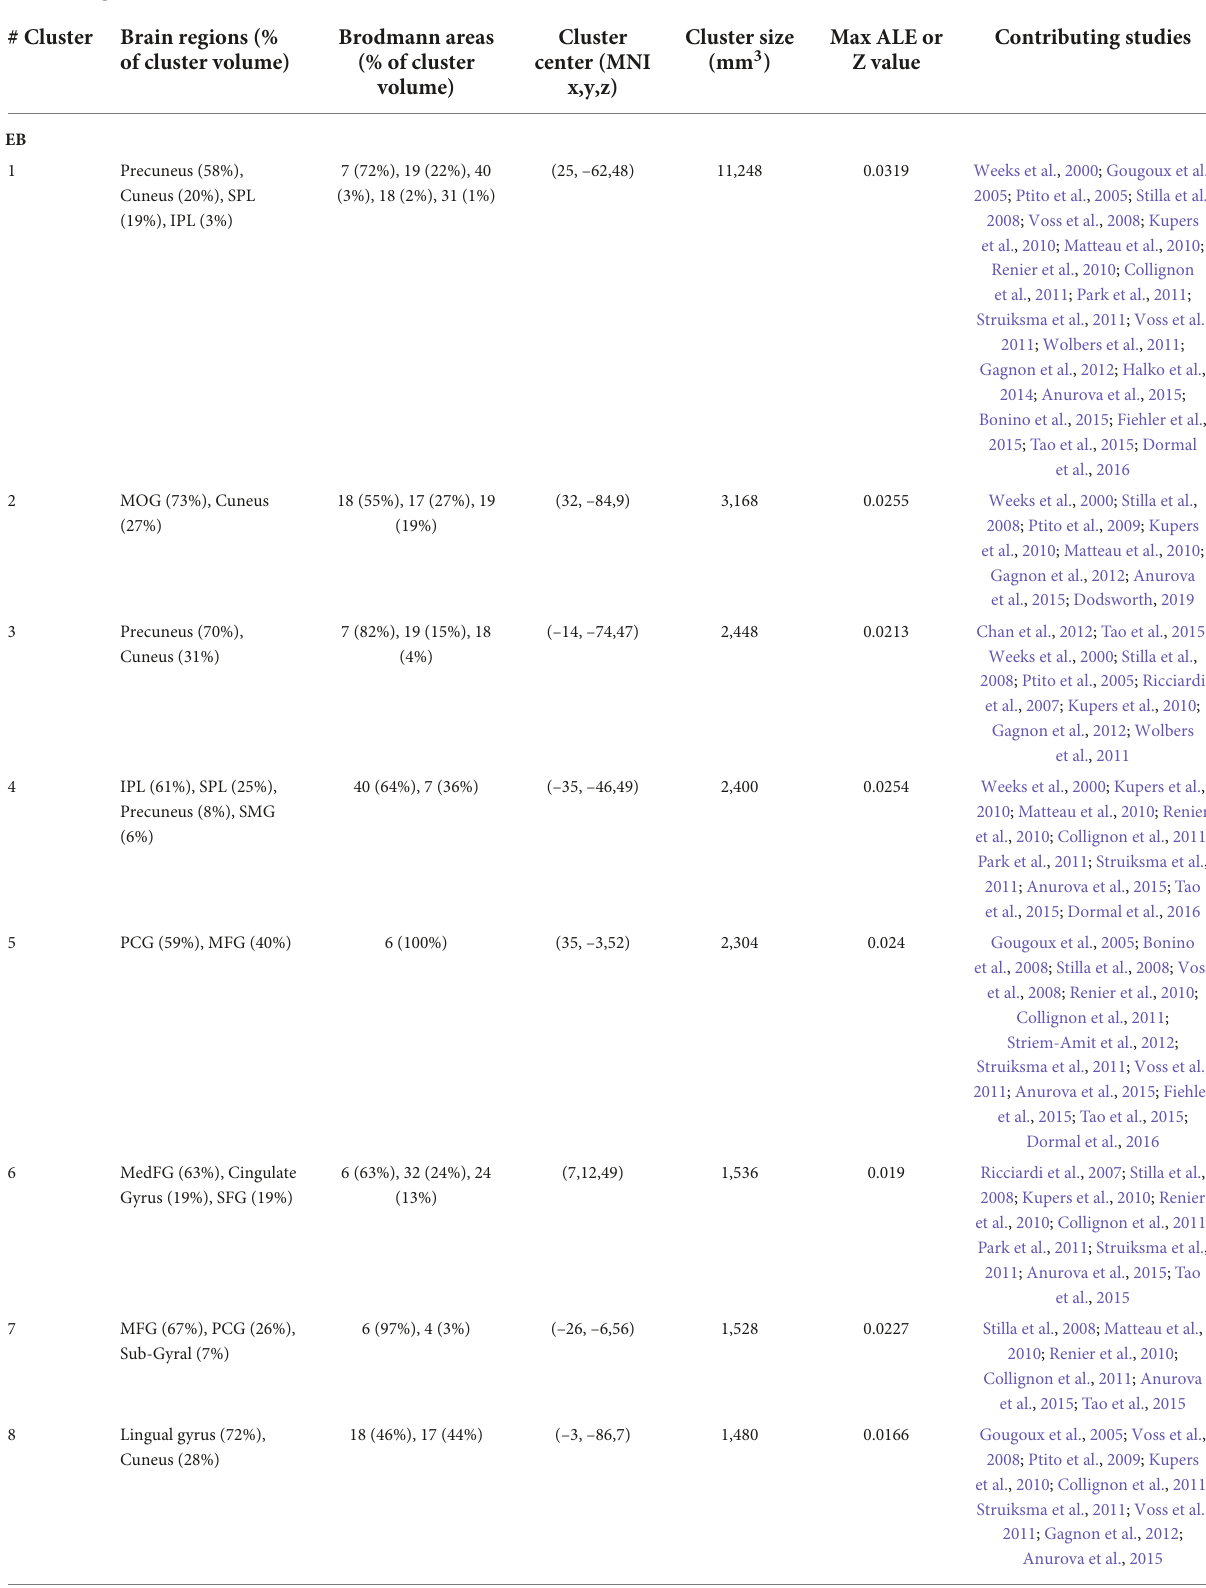
TABLE 5 Brain clusters obtained from the activation likelihood estimation (ALE) meta-analysis for spatial processing + spatial navigation and contributing studies. # Cluster Brain regions (% of cluster